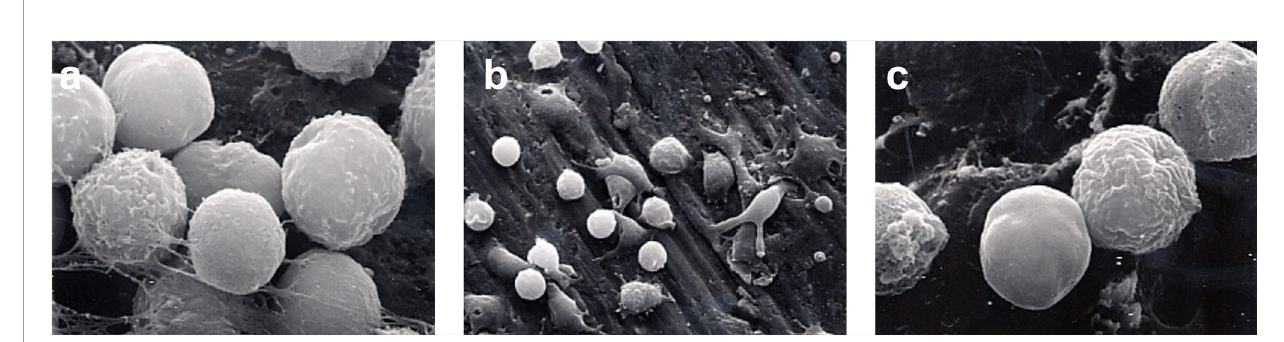
FIGURE 5 | Monocyte apoptosis. SEM photomicrographs 60-min following secondary stimulation with PMA 10 -5 M. (A) 5000x magni fi cation of Group 1. The continued loss of surface features compared to earlier time periods is noted. (B) 1250x magni fi cation of Group 4. Monocytes have lost the ruf fl ed border with many cells showing signs of apoptosis. (C) 5000x magni fi cation of Group 5. Loss of surface features and onset of apoptosis